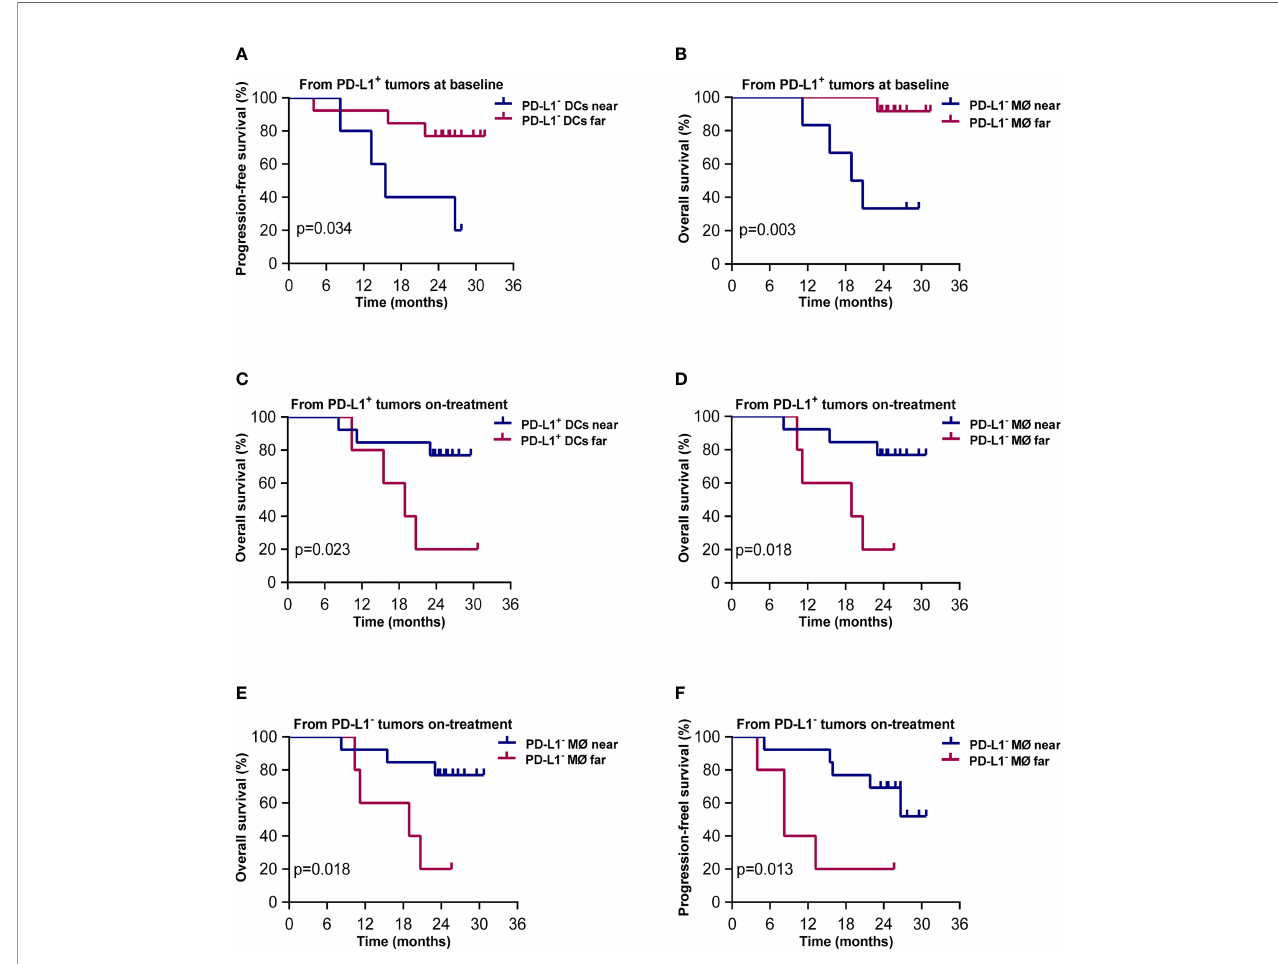
FIGURE 7 | Spatial distribution of dendritic cell and macrophage subsets associated with survival. Kaplan – Meier curves showing overall and progression-free survival based on distance from (A) PD-L1 + tumor cells to the nearest PD-L1 - dendritic cells at baseline; (B) PD-L1 + tumor cells to PD-L1 - macrophages at baseline; (C) PD-L1 + tumor cells to the nearest PD-L1 + dendritic cells during treatment; (D) PD-L1 + tumor cells to the nearest PD-L1 - macrophages during treatment; (E) PD-L1 - tumor cells to the nearest PD- L1 - macrophages during treatment; (F) PD-L1 - tumor cells to the nearest PD-L1 - macrophages during treatment. Cutoff value: (A) 57.694 m m; (B) 66.762 m m; (C) 49.136 m m; (D) 103.159 m m; (E) 81.396 m m; (F) 81.396 m m. On-treatment, after 40 Gy radiation. p ≤ 0.05, statistically signi fi